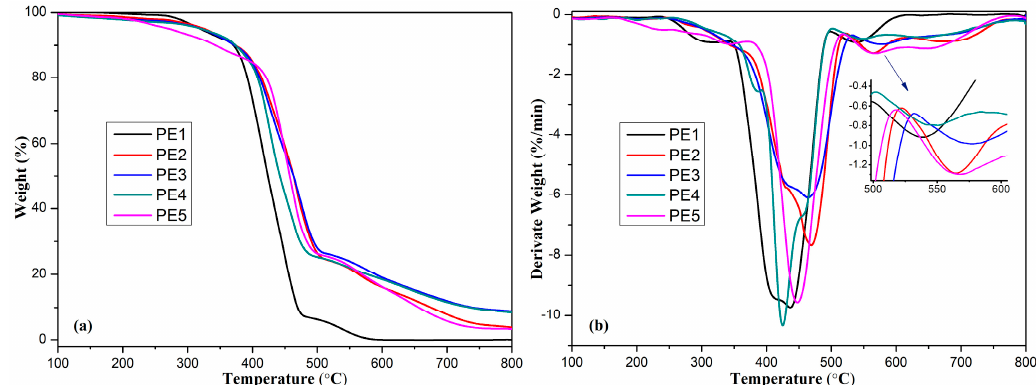
/ IFR composites in air atmosphere. Polymers 2018 , 10 , x FOR PEER REVIEW